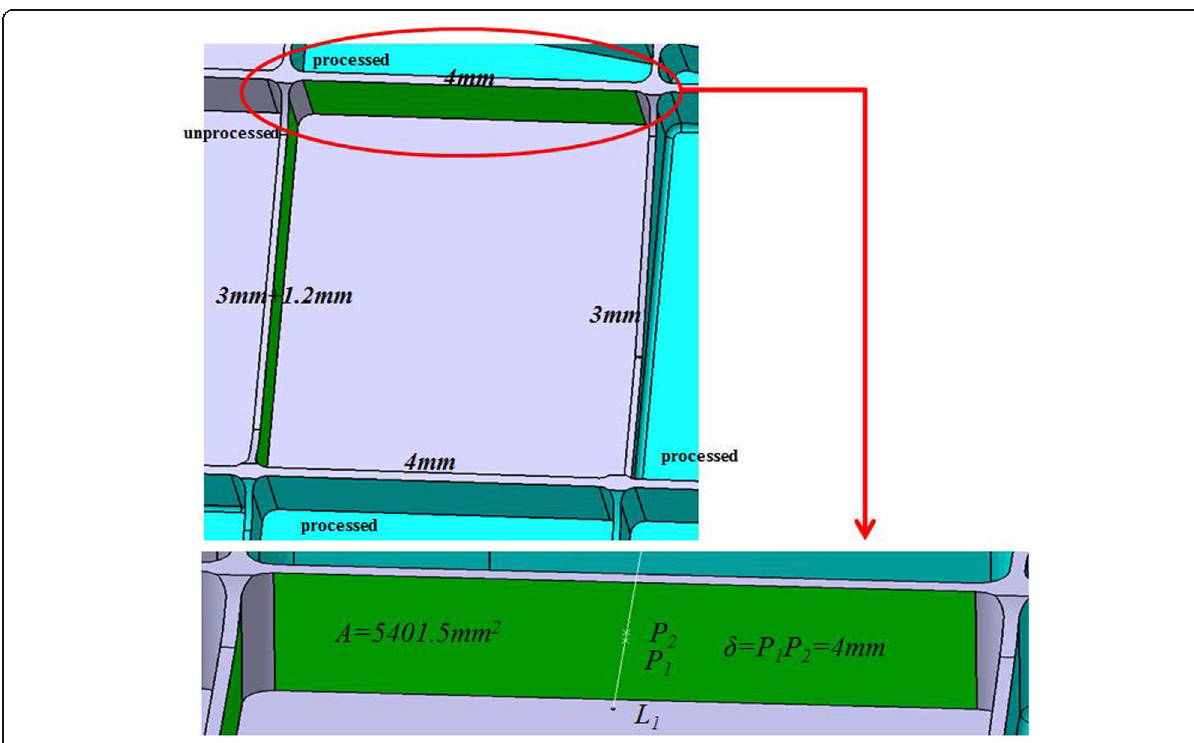
Fig.8 A pocket feature of the thin-walled